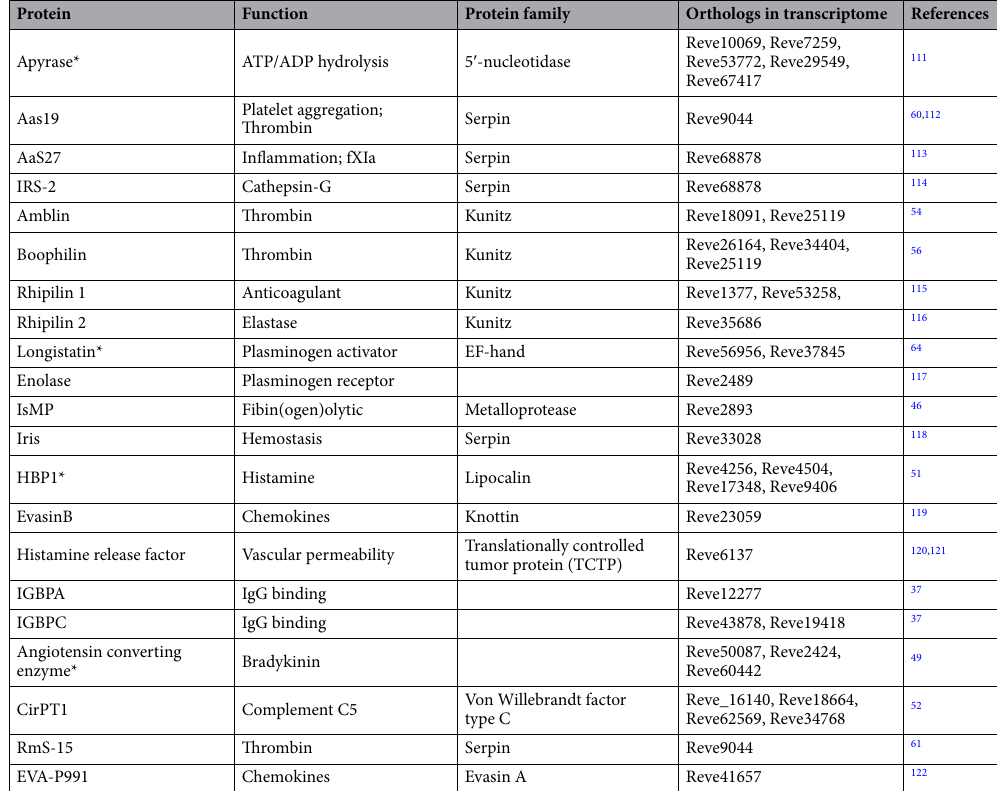
Table 2. Orthologs identified in the Rhipicephalus evertsi evertsi transcriptome for proteins with known functions. Those proteins with asterisks are considered orthologous to ancestral tick lineages of platelet aggregation inhibitors, blood clotting inhibitors and immune-modulators 26 . Orthologs were confirmed by phylogenetic analysis and were included if the homologs grouped within a well-defined orthologous clade with good bootstrap support that included the sequence with experimental confirmed